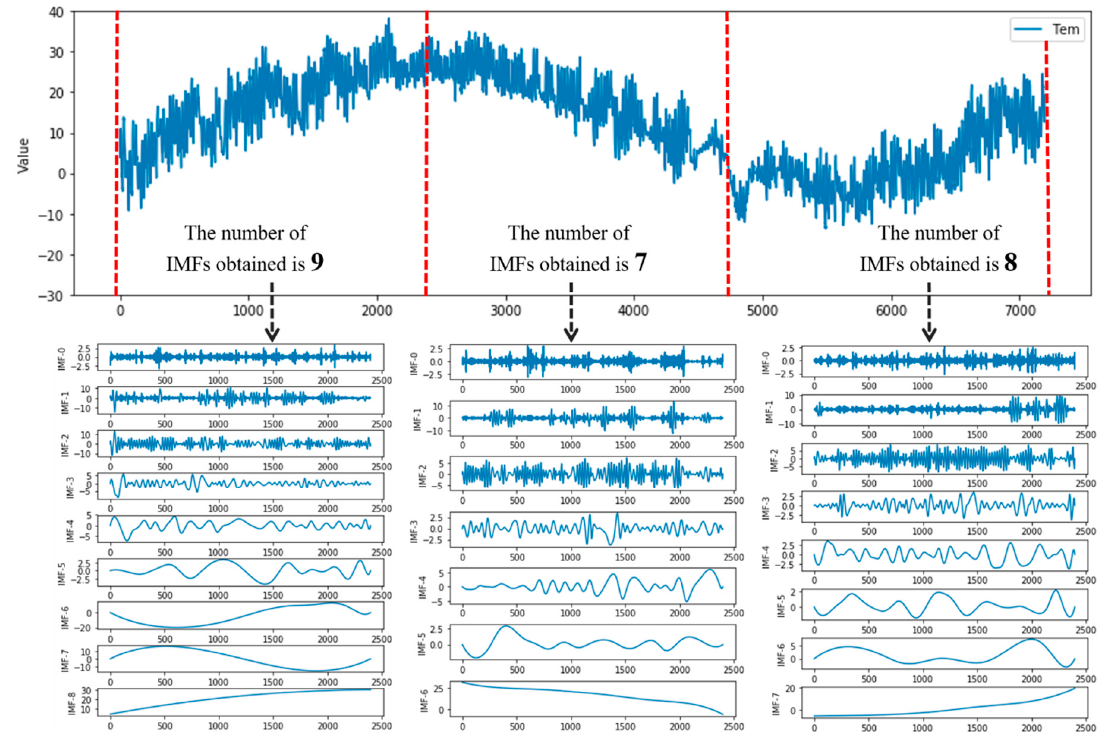
Figure 3. The number of IMFs within different time intervals of temperature data.